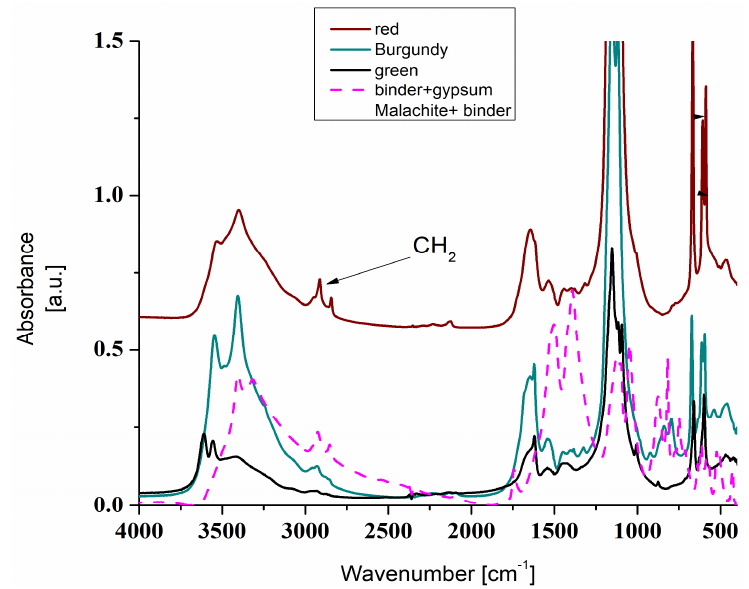
Figure 12. FTIR spectra of the painting materials, 4000 to 400 cm −1 spectral range, Oy extended.